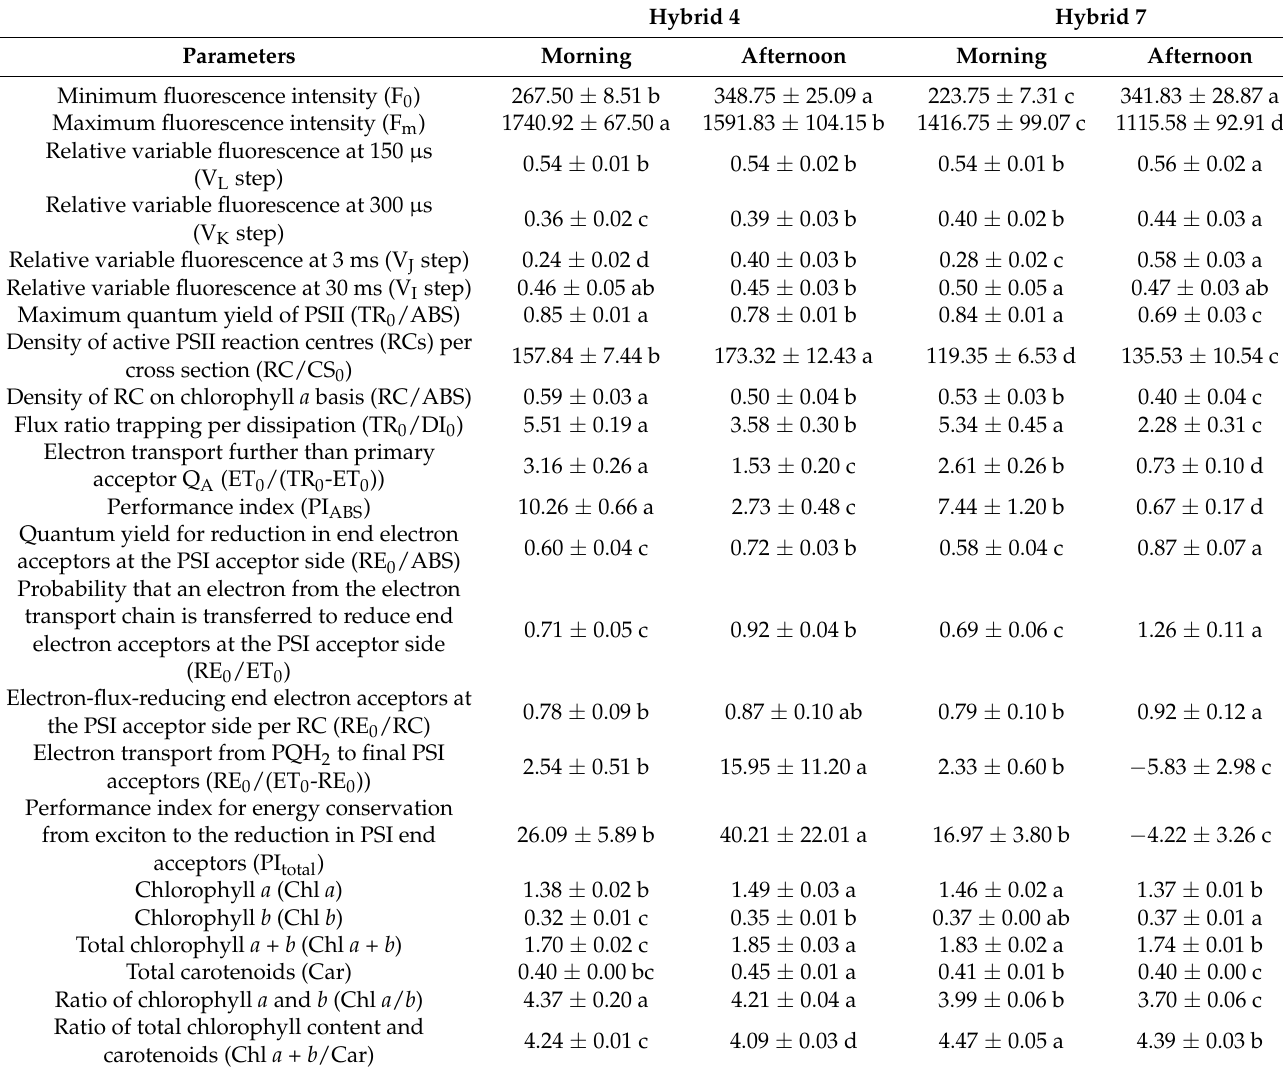
Table 1. Mean values and standard deviations of JIP parameters ( n = 12) and photosynthetic pigment contents ( n = 5) in sunflower hybrids 4 and 7 in morning and afternoon